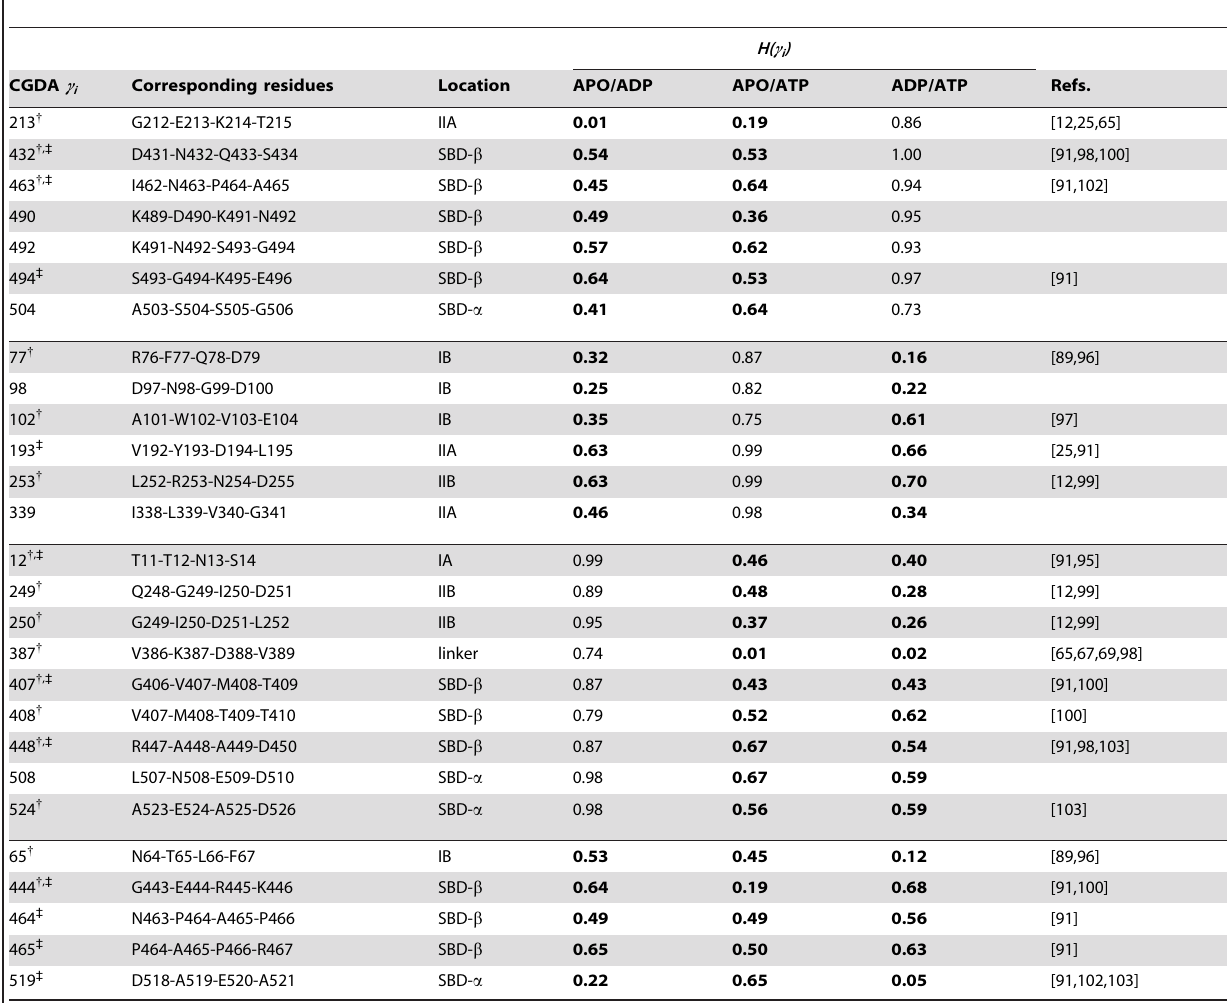
Table 3. List of the 27 CGDAs c revealed by analysis of 1-D FEPs of DnaK in different nucleotide-binding states and their corresponding amino acids.